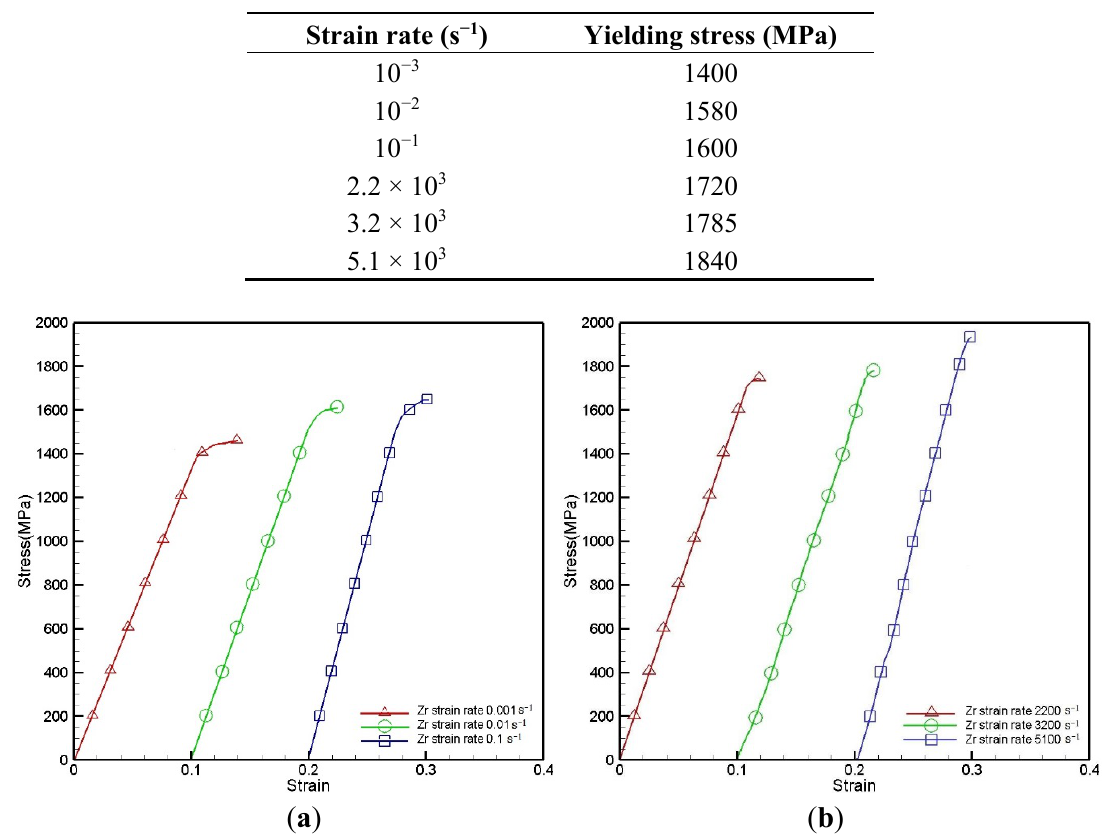
Table 1. Yield stress of Zr-based metallic glass under different strain rates.